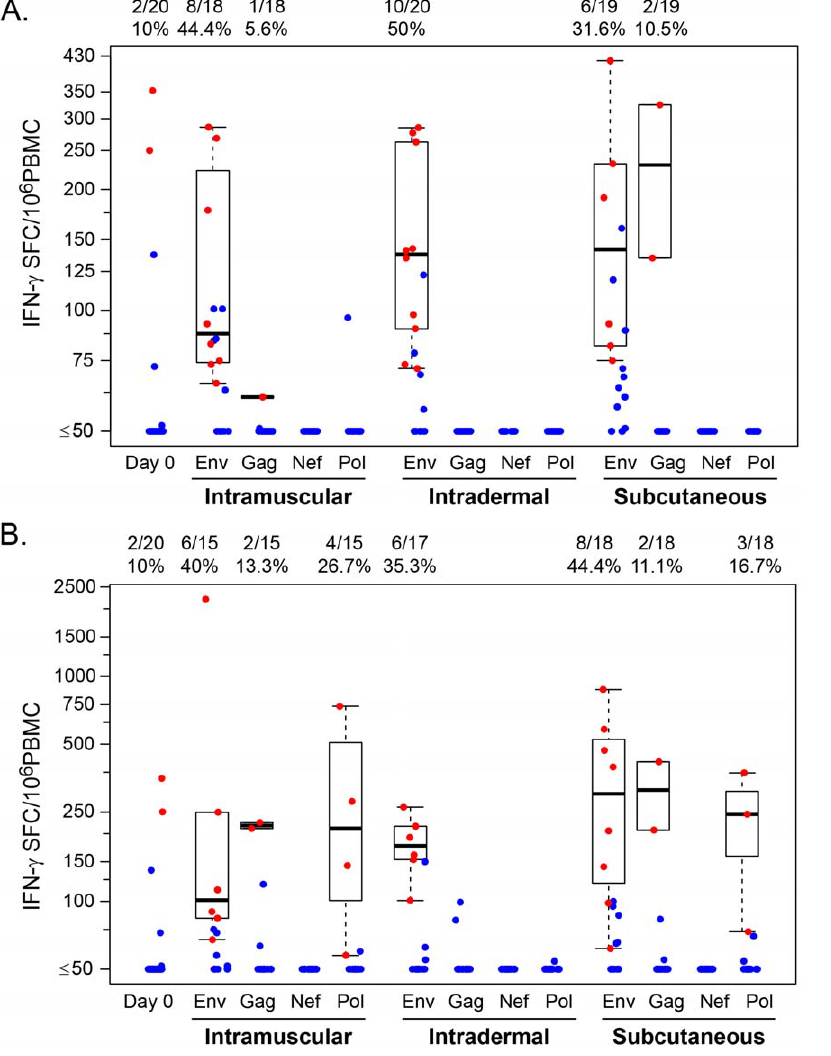
Figure 3. Interferon- c ELISpot response to Env, Gag, Nef, Pol global PTE peptide stimulation by administration route. (A) At 2 weeks post last DNA prime and (B) 4 weeks post Ad5 boost. The scale indicates spot-forming cells per million peripheral blood mononuclear cells.